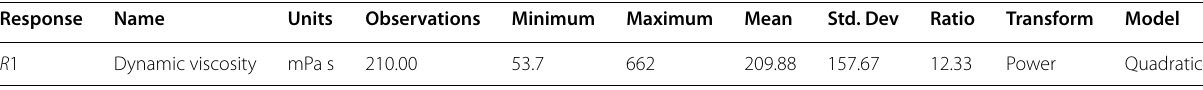
Table 8 Response feature of the RSM model Response